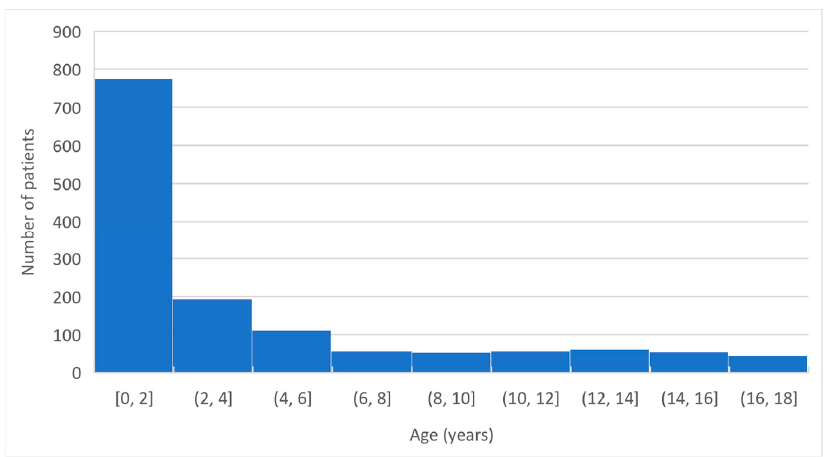
Figure 1. The age structure of the hospitalized children.